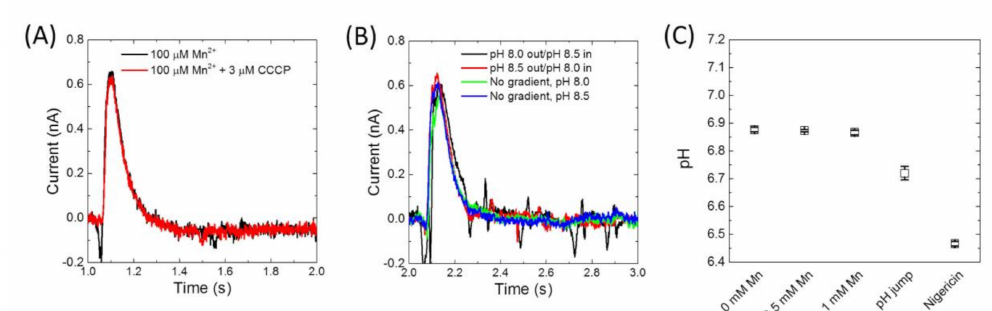
Figure 6. ( A ) Electrophysiology experiments of his-tagged MntH2 proteoliposomes (LPR 10:1 ( w / w )) in 10 mM HEPES, pH 8.0, 150 mM KCl and 2 mM MgCl 2 in the presence and absence of 3 µ M CCCP. Mn(II) was initiated by the addition of 100 µ M MnCl 2 . ( B ) Same as ( A ), except some experiments were performed in the presence of a pH gradient. pH gradients were formed by (black line) exchanging the sensor bu ff er of pH 8.5, with a bu ff er of pH 8.0 at t = 0 s, followed by the addition of 100 µ M Mn(II) at t = 2 s also in pH 8.0. A similar, but opposite sequence was used for the red line. The pH gradient had to be formed prior to adding Mn(II) as changing pH also produces transient electrical currents. ( C ) Fluorescence experiments of HPTS encapsulated his-tagged MntH2 proteoliposomes (LPR 70:1 ( w / w )) in 5 mM MOPS, pH 7.0, 150 mM KCl. HPTS was used to measure the lumen pH of the proteoliposomes after consecutively adding 0.5 mM MnCl 2 , 1 mM MnCl 2 , 0.5 mM HCl (which lowers the pH to ~6.5) and 0.1 µ M nigericin. Each addition and measurement are ~2 min apart. The fact that the lumen pH does not immediately equilibrate fully after addition of 0.5 mM HCl indicates that proteoliposomes are able to maintain a pH gradient on this